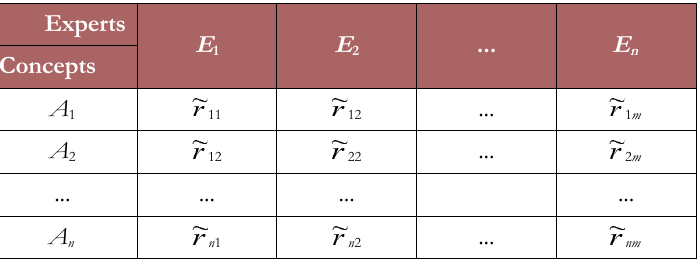
Table 2. Intuitionistic fuzzy matrix of